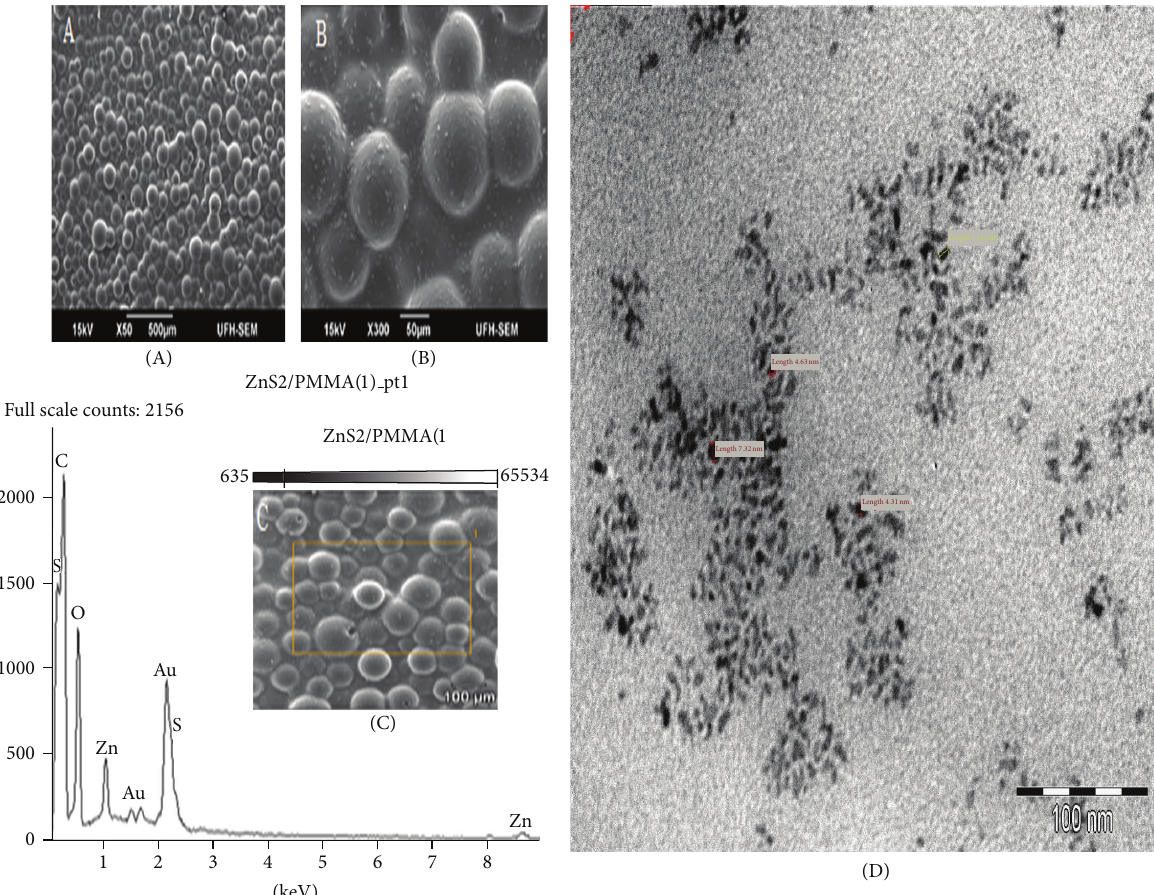
Figure 4: (A) and (B) are SEM micrograph of ZnS2/PMMA nanocomposites at different magnification; (C) EDX spectrum of the sample; (D) TEM